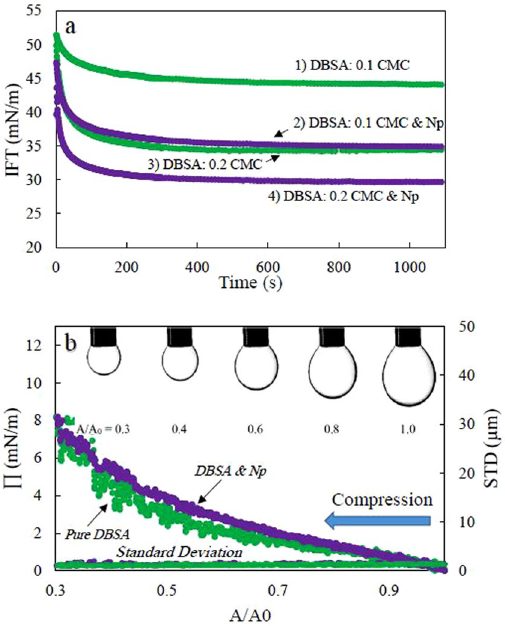
Figure 8. ( a ) The effect of nanoparticles (Levasil 300/30, 2.5 wt.%) on dynamic IFT of heptane/DBSA solution at two different surfactant concentrations. 1,3: pure DBSA, 2,4: DBSA & Np, ( b ) Variation of surface pressure and standard deviation of fitting the Laplace equation to drop profiles during drop compression of a DBSA solution (1.6 × 10 − 5 M: 0.1 CMC) in absence and presence of 2.5 wt.% nanoparticle (Levasil 300/30, 9 nm). Π : surface pressure, STD: the standard deviation of fitting the Laplace equation to the drop profiles, A/A0: the normalized surface area of droplet in respect to its initial value. No wrinkles appear at the drop surface during the compression process. The average error for IFT and surface pressure results is less than 0.7 mN/m and for standard deviation results is